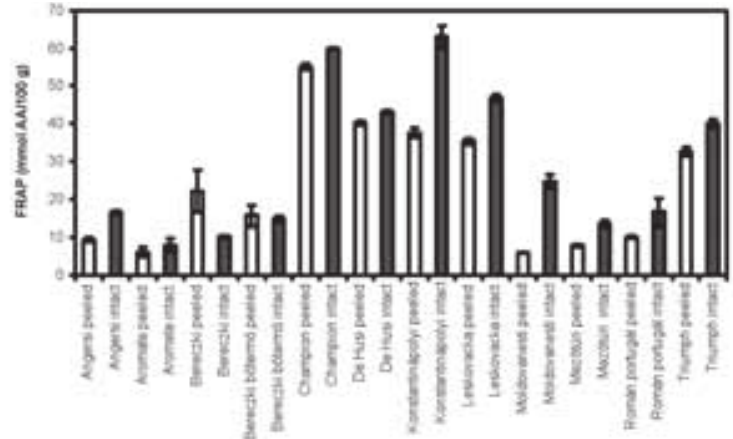
Figure 1 Antioxidant capacity in peeled (white columns) and intact (grey columns) fruits of Cydonia oblonga genotypes harvested in 2010, Újfehértó, Hungary